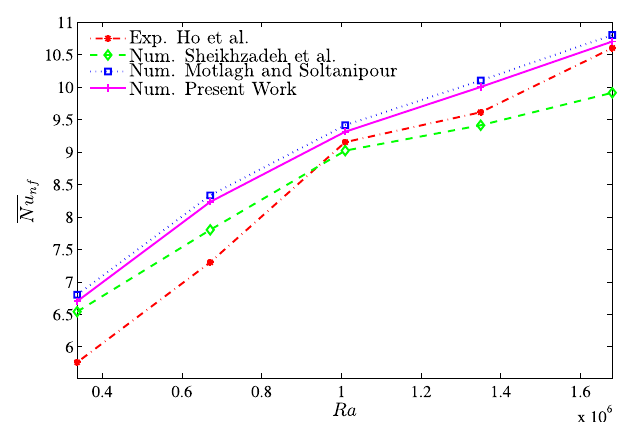
Figure 4. Comparison of the mean Nusselt number obtained from present numerical simulation with the experimental results of Ho et al . 44 , numerical results of Sheikhzadeh et al . 45 and numerical results of Motlagh and Soltanipour 20 for different values of Rayleigh